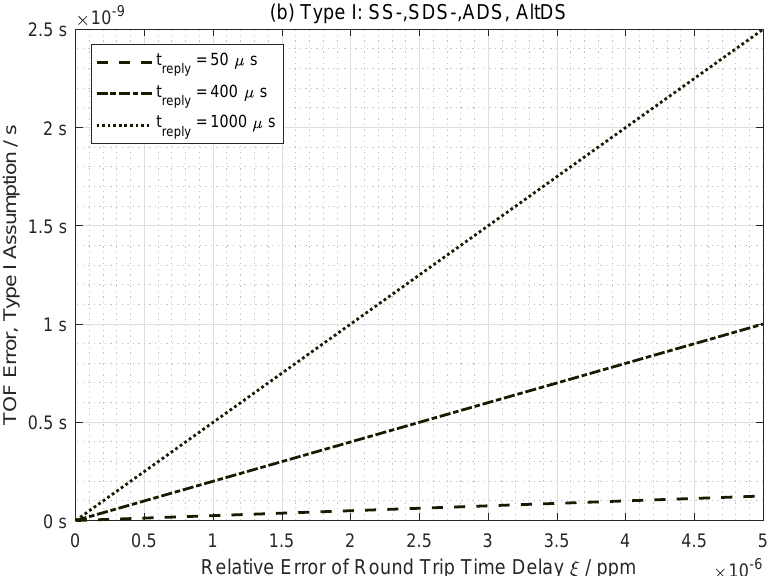
Figure 3. TOF error comparison using a Type I assumption (ideal case) as in Equation (23) ( c (cid:13) 2018 IEEE. Reprinted, with